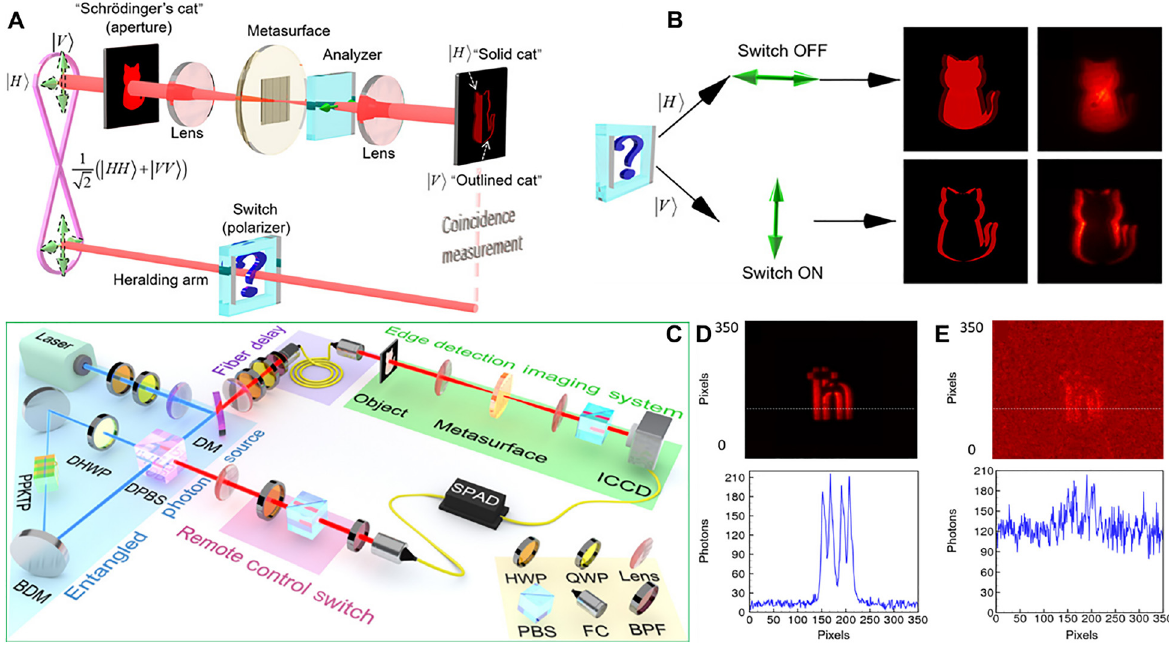
Figure 9: Quantum switchable edge detection based on PB phase metasurface [43]. (A) Schematic of experimental setup for switchable quantum edge imaging. (B) The polarization switch controls the coincidence image: Polarization | H >isOFFstate,correspondingtothebright fi eldmode “ solidcat ” (the fi rstrowshowssimulationandexperimentalimaging); | V > state is ON state, corresponding to edge detection mode “ outlined cat ” (the second row shows simulation and experimental imaging). (C) Experimentalsetupformetasurfaceenabledquantumedgedetection.BDM,broadbanddielectricmirror;PPKTPcrystal,periodicallypolarized KTiOPO4 crystal; DPBS, dual-wavelength polarization beam splitter; PBS, polarization beam splitter; DM, dichroic mirror; FC, fi ber coupler; BPF,band-pass fi lter;DHWP,dual-wavelength1/2waveplate;QWP,1/4waveplate;SPAD,singlephotonavalanchedetector;ICCD,intensi fi ed charge coupled device. The blue (red) light path presents the 405 nm (810 nm) light. The edge detection switch is on the forecastend, and the edge detection system is installed on the imaging end. (D) Coincident edge image of photon pair in external trigger mode and the one- dimensional intensity distribution along the white dashed line. (E) Edge image in internal trigger mode and the one-dimensional intensity distribution along the white dashed